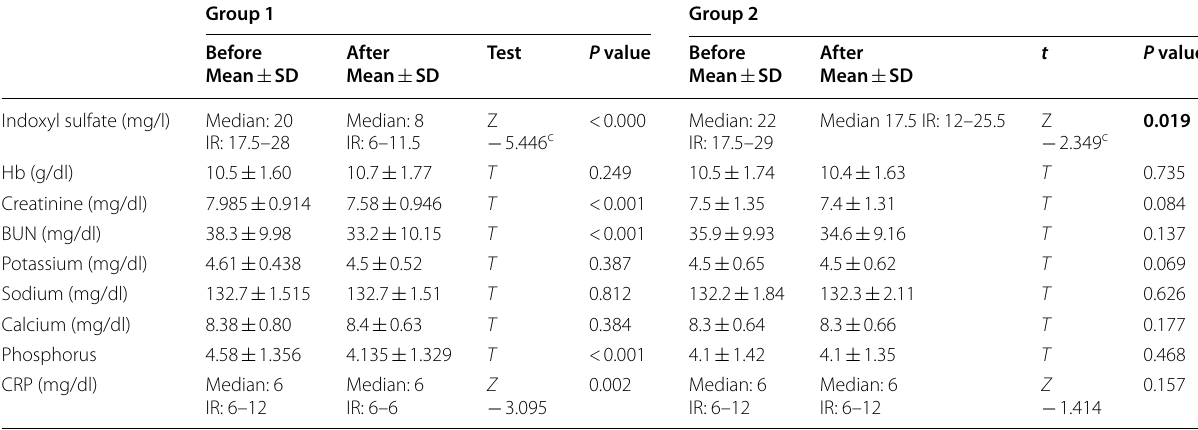
Table 2 Comparison in both groups at baseline and after 6 weeks of SYN or placebo supplementation as regards different laboratory results